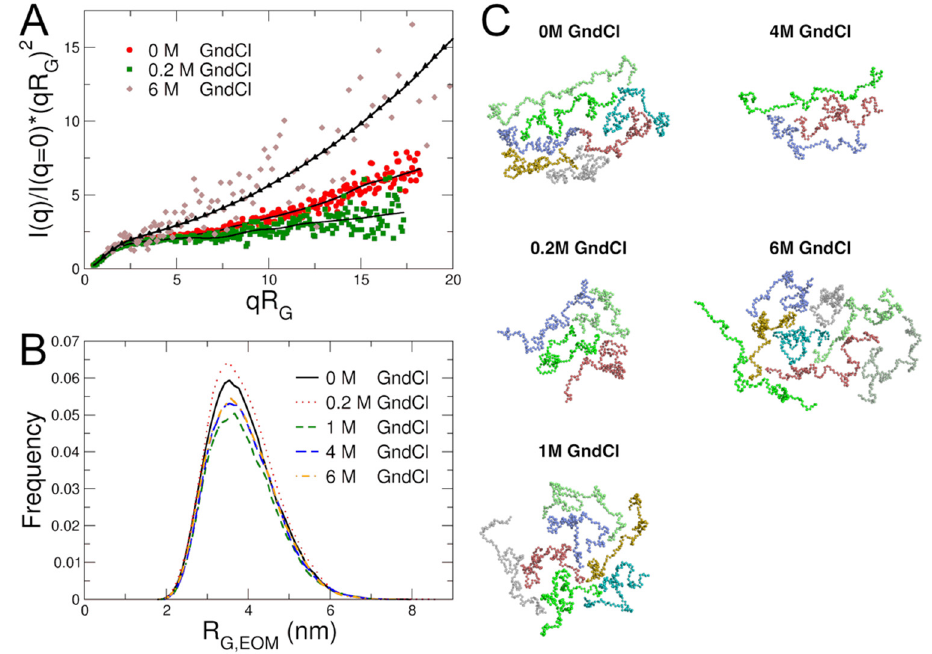
Figure 3. Results from EOM analysis. ( A ) Experimental SAXS data at different GndCl concentrations and fits using EOM modelling. Symbols represent experimental data; solid black lines are theoretical fits using EOM modelling; black triangles indicate the fitted generalized Gauss curve that was used as input for the EOM simulation of MBP in 6 M GndCl. ( B ) Radii of gyration distribution of MBP obtained from EOM analysis as function of GndCl concentration. ( C ) Coarse-grained structural models of MBP at different GndCl concentrations that appeared most frequently during EOM modelling. Structural models were used as representations of the conformational ensemble of MBP and as test models for normal mode analysis of NSE data.